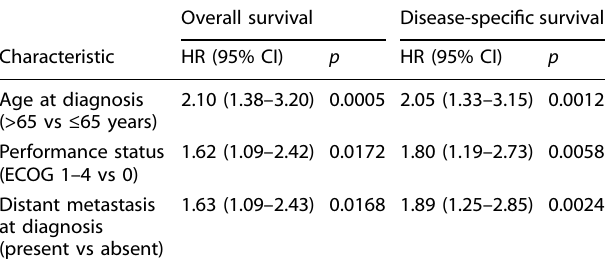
Table 4. Multivariate survival analysis of the entire study